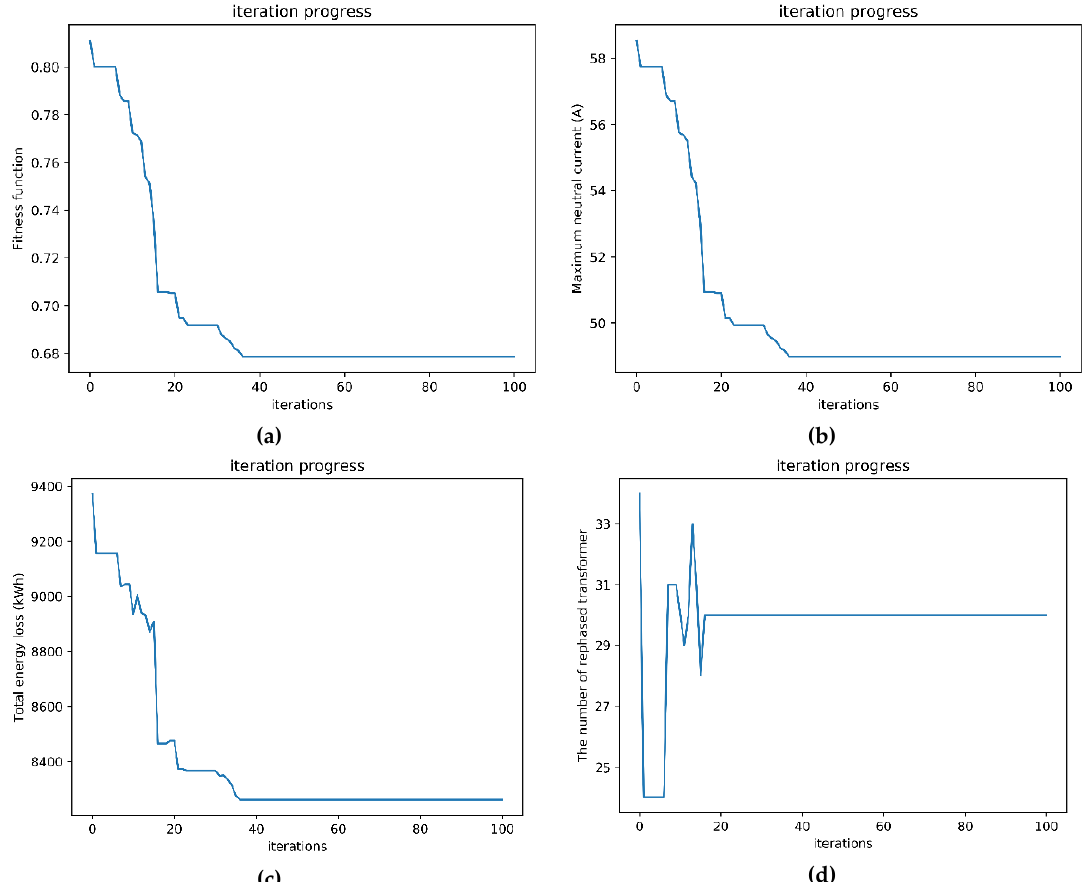
Figure 10. The iterative convergence diagram: ( a ) fitness function, ( b ) neutral current, ( c ) total energy loss, and ( d ) rephasing number. Energies 2020 , 13 , x FOR PEER REVIEW